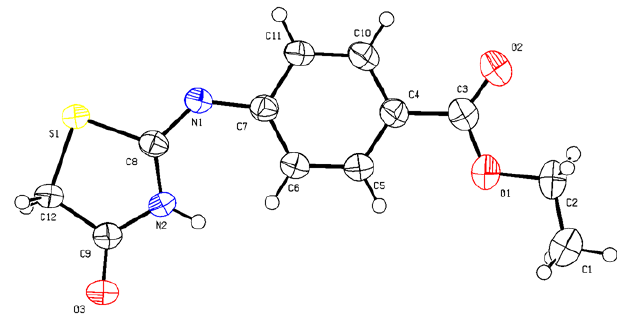
Figure 4. ORTEP plot of the X-ray crystallographic data determined for 3d . Crystallo- graphic data have been deposited with the Cambridge Crystallographic Data Centre as supplementary publication number CCDC 874279 [31].